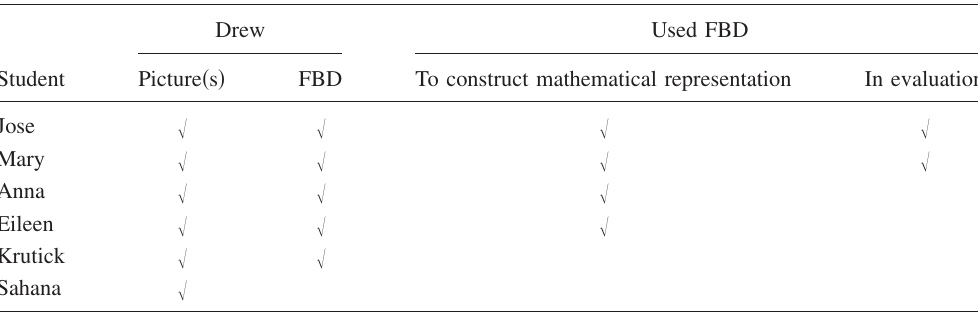
TABLE VII. Comparison of